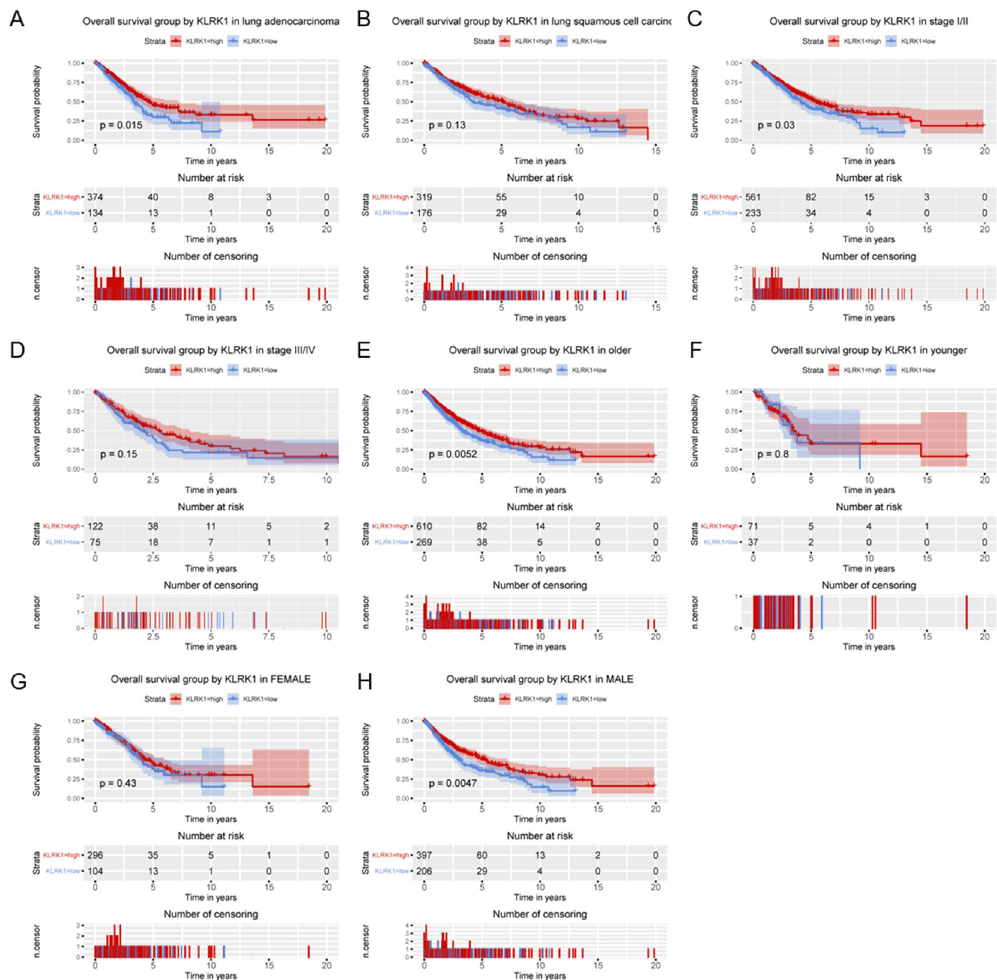
Figure 7. Relationship of KLRK1 expression with overall survival in all patients with lung cancer in ( A ) lung adenocarcinoma, ( B ) lung squamous cell carcinoma, ( C ) stage I/II, ( D ) stage III/IV, ( E ) older patients, ( F ) younger patients, ( G ) female and ( H )